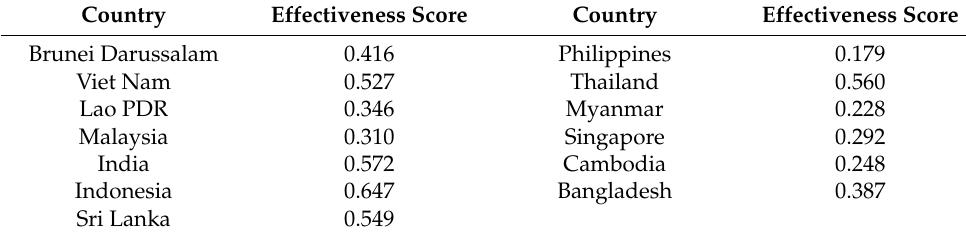
Table A8. SfRDMA